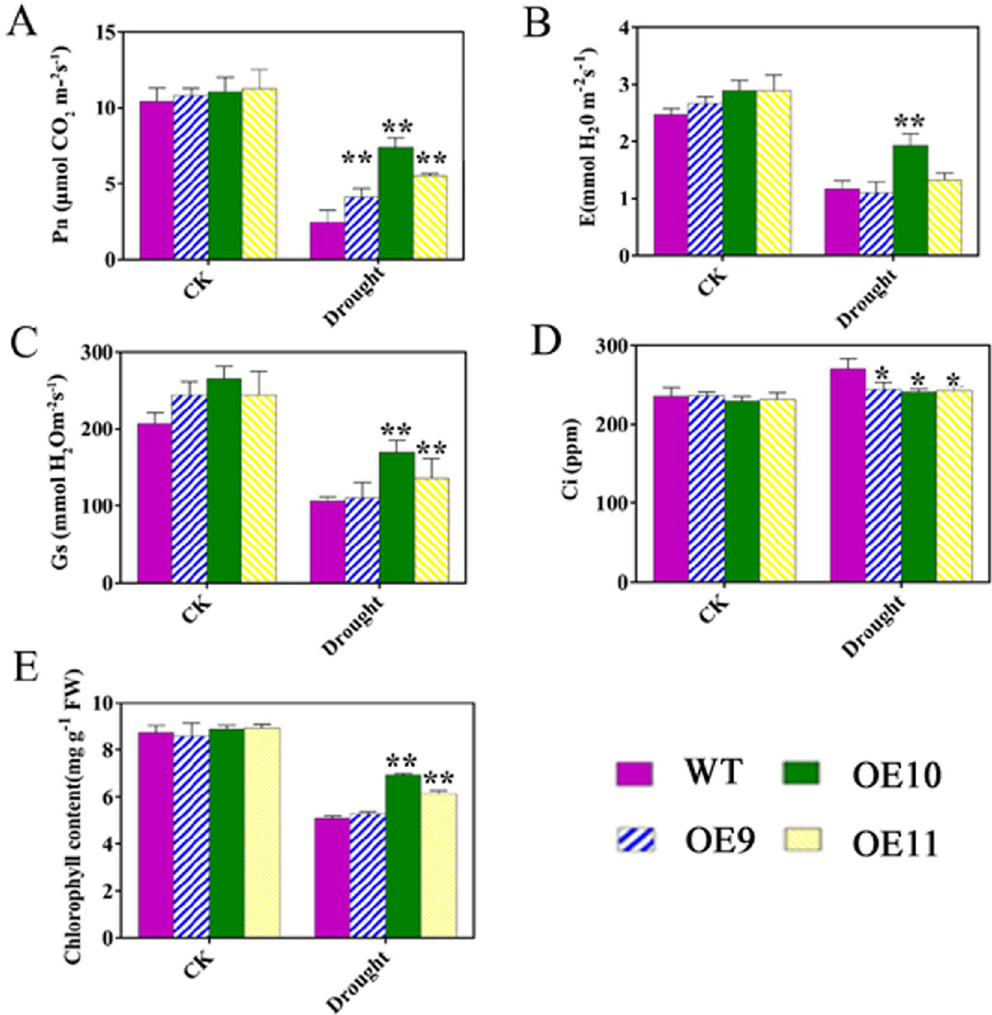
Figure 3. Photosynthetic performance of TaPUB1 -overexpressing lines and WT plants after drought treatment. ( A ) Net photosynthetic rate, Pn. ( B ) Transpiration rate, E. ( C ) Stomatal conductance, Gs. ( D ) Intercellular CO 2 concentration, Ci. (E) Chlorophyll content. The experiments were repeated three times and the bars indicate SEs. * and ** indicate significant differences at P < 0.05 and P < 0.01 among the three overexpression lines and the WT